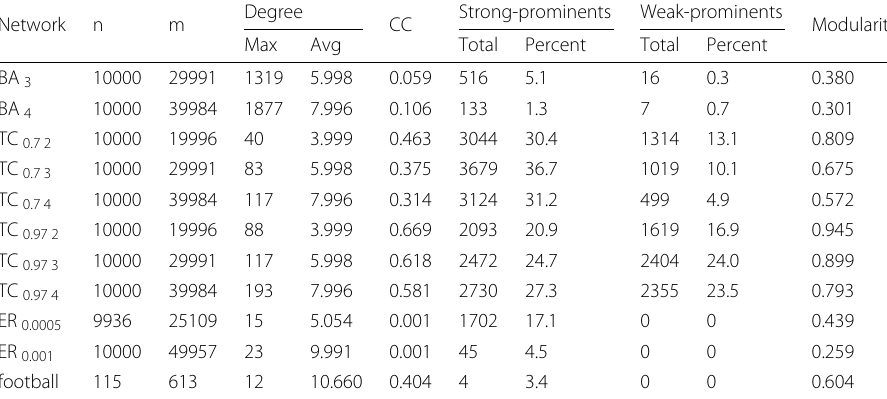
Table 6 Properties of generated